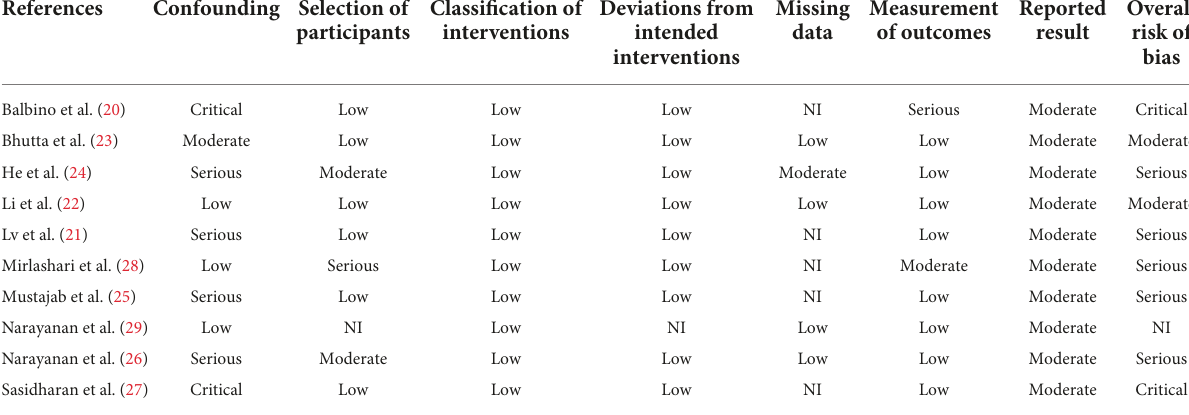
TABLE 2 Risk of bias of non-randomized trials using ROBINS-I tool